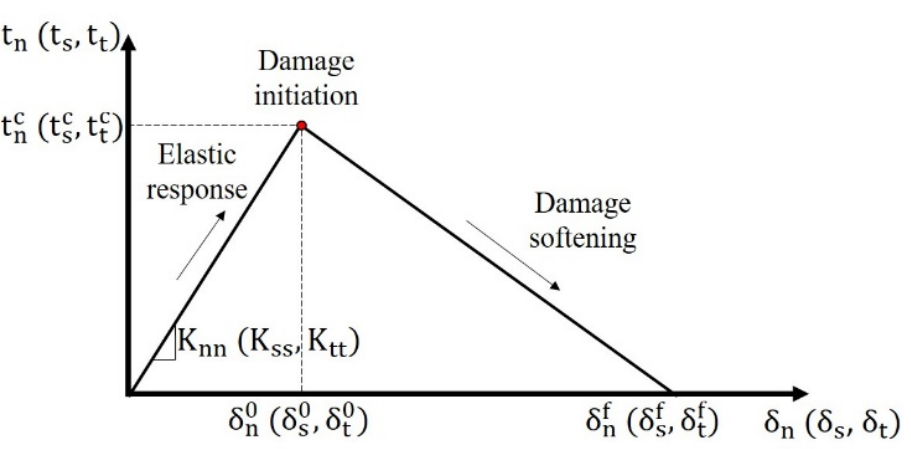
Figure 11. Interface joint traction-separation response in tension and shear.